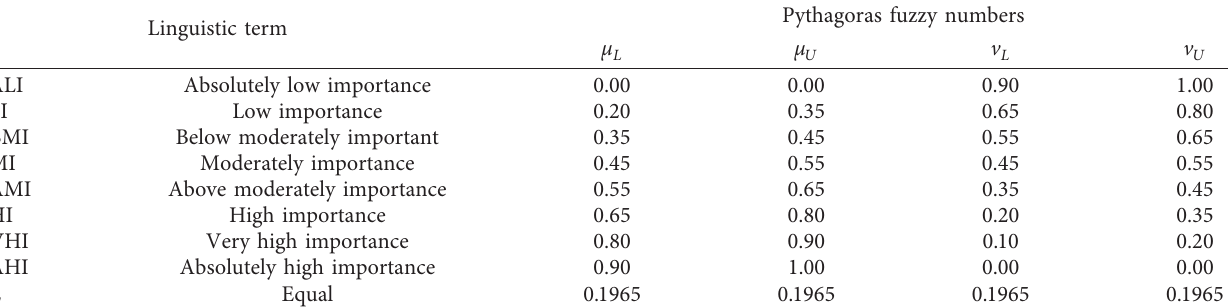
Table 2: Pythagorean fuzzy AHP weighting scale [24].